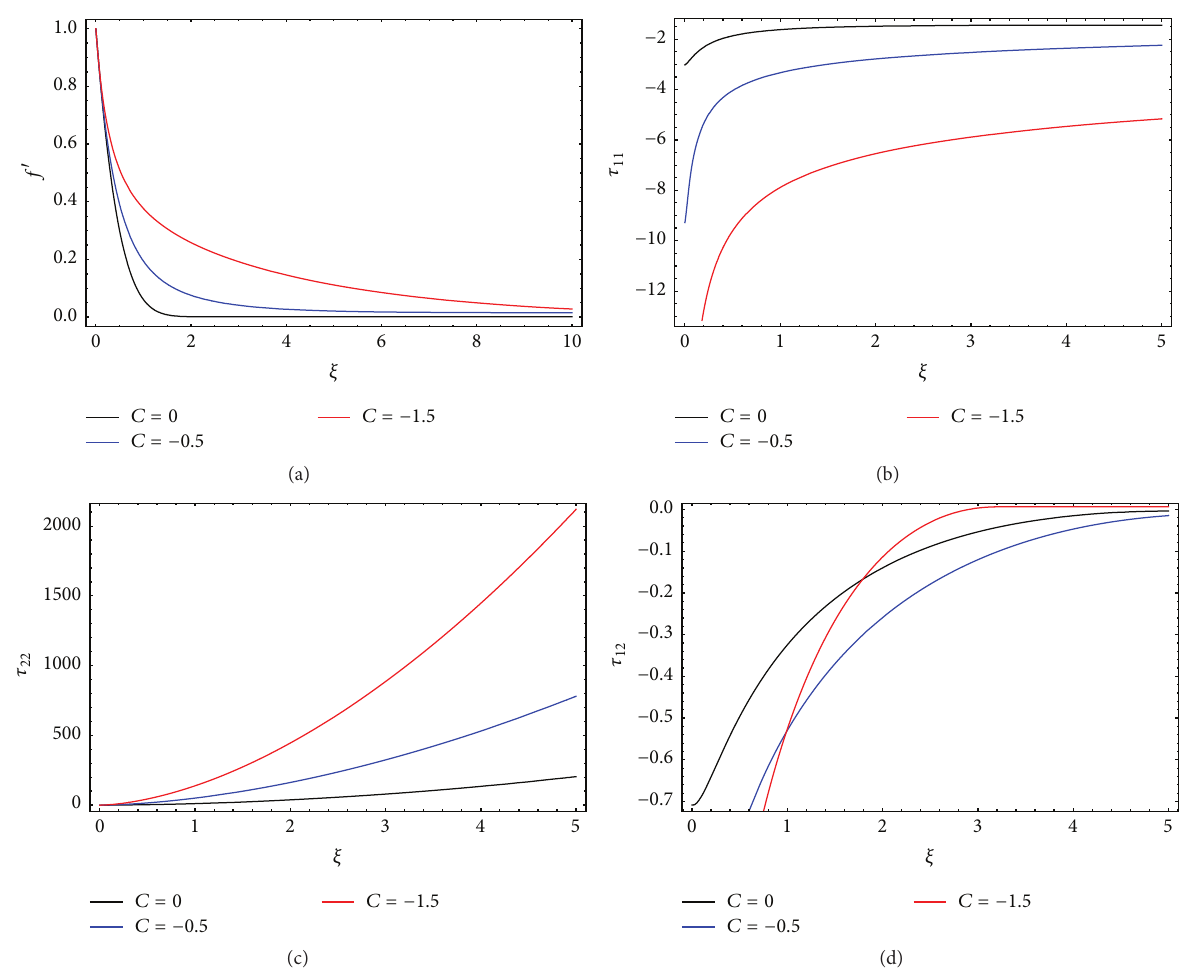
Figure 2: Velocity and stress profiles for several values of pressure gradient constant, C .